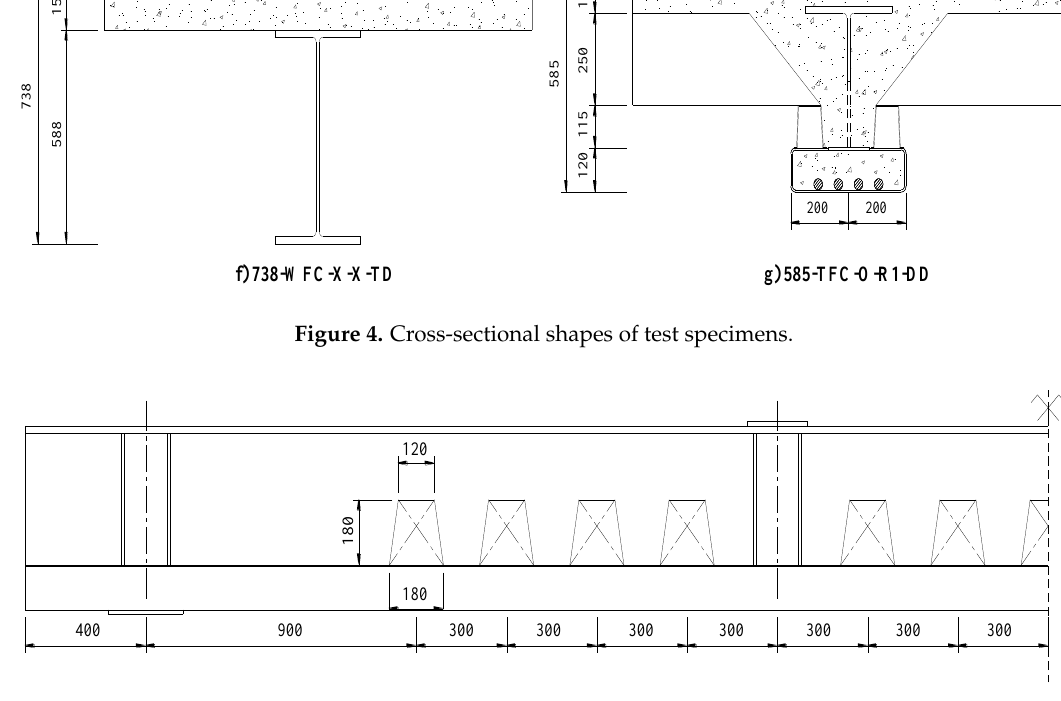
Figure 5. Web opening details of test specimens. Table 2. Concrete material properties (unit: N/mm 2 ).